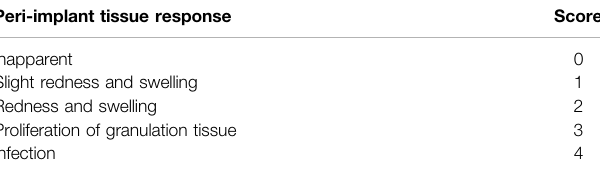
TABLE 1 | Peri-implant tissue response